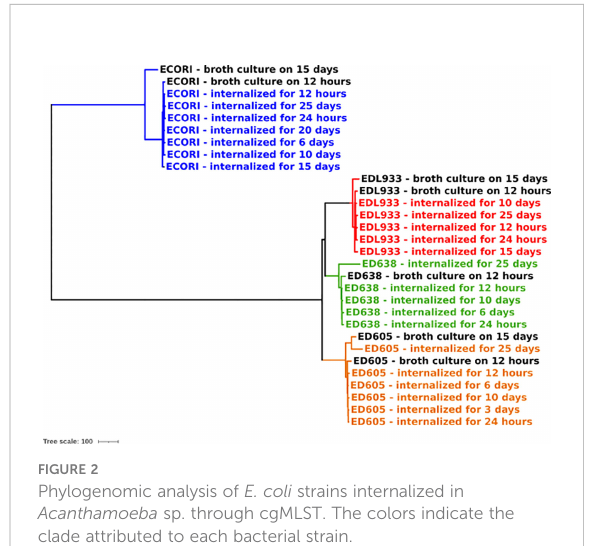
FIGURE 2 Phylogenomic analysis of E. coli strains internalized in Acanthamoeba sp. through cgMLST. The colors indicate the clade attributed to each bacterial